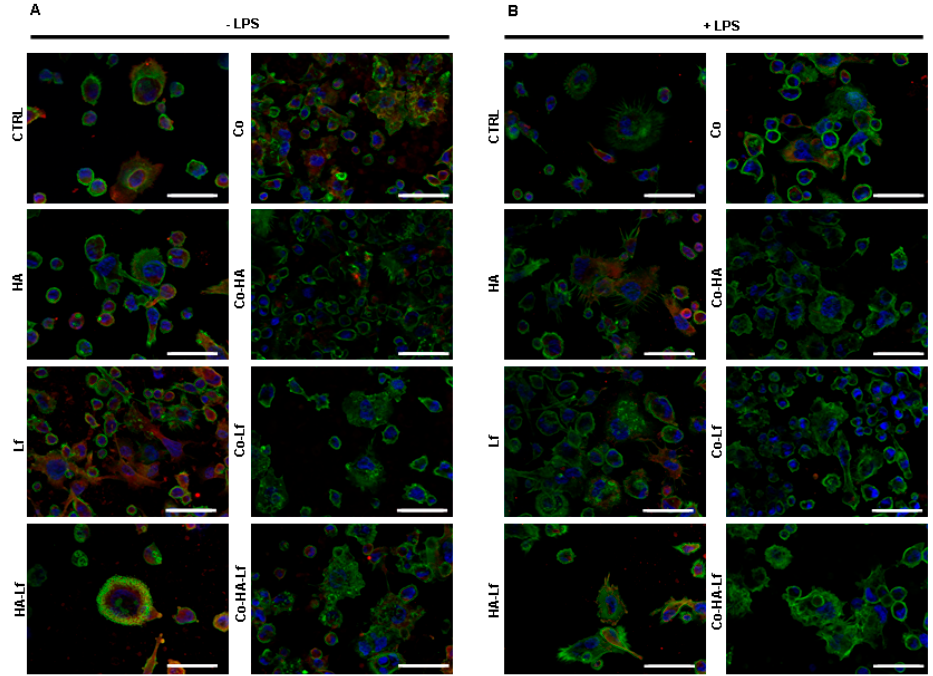
Figure 4. Adhesion and distribution of di ff erentiated THP-1 cells on materials covered with biomimetically modified surfaces in the absence of ( A ) or in the presence of ( B ) lipopolysaccharide (LPS). Representative images of the attached cells 40 × obtained by fluorescence microscopy by marking actin (green), vinculin (red), and nucleus (blue). Scale bar is 50 µ m. HA: hydroxyapatite; Lf: